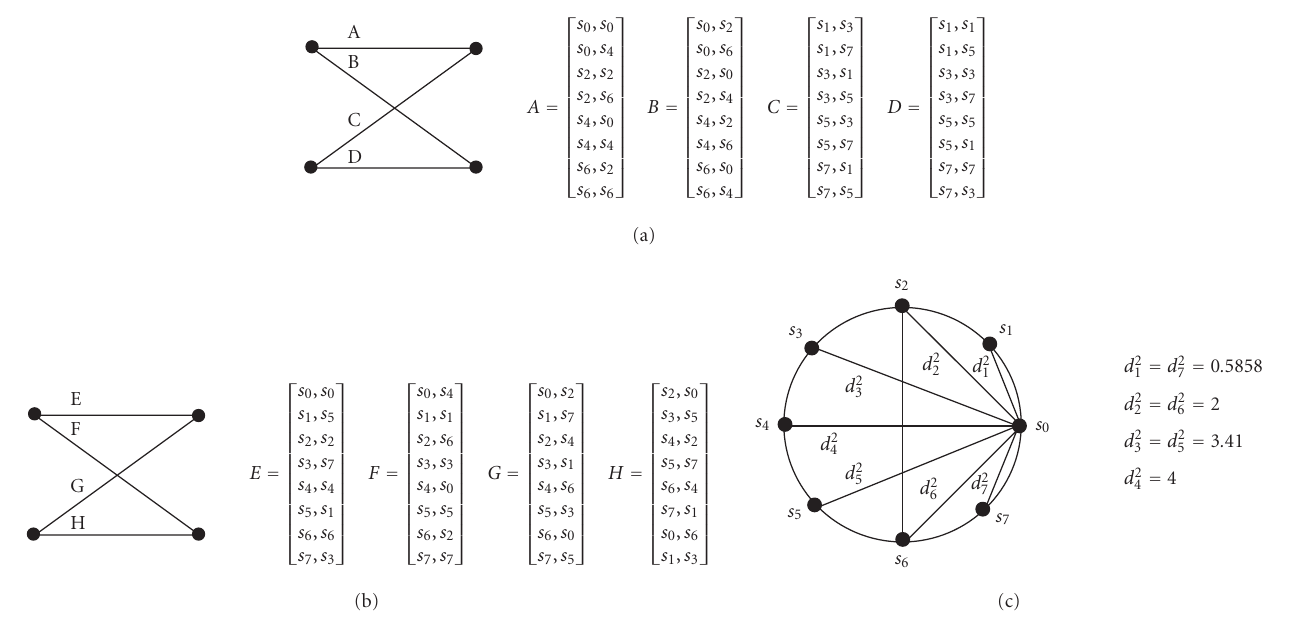
Figure 1: (a) Code A2, optimum for AWGN, (b) Code F2, optimum for Rayleigh fading channels with one transmit antenna, (c) 8-PSK signal constellation.